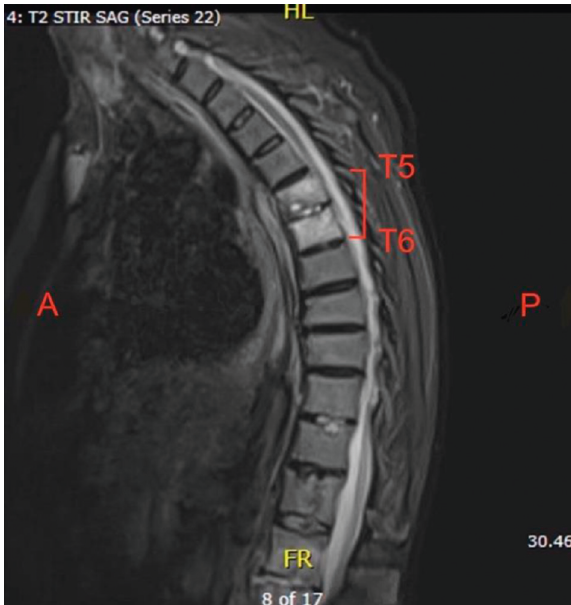
Figure 4: MRI thoracic spine with findings of discitis/osteomyelitis involving T5-6 with trace enhancement of the left anterior T5-6 epidural space.